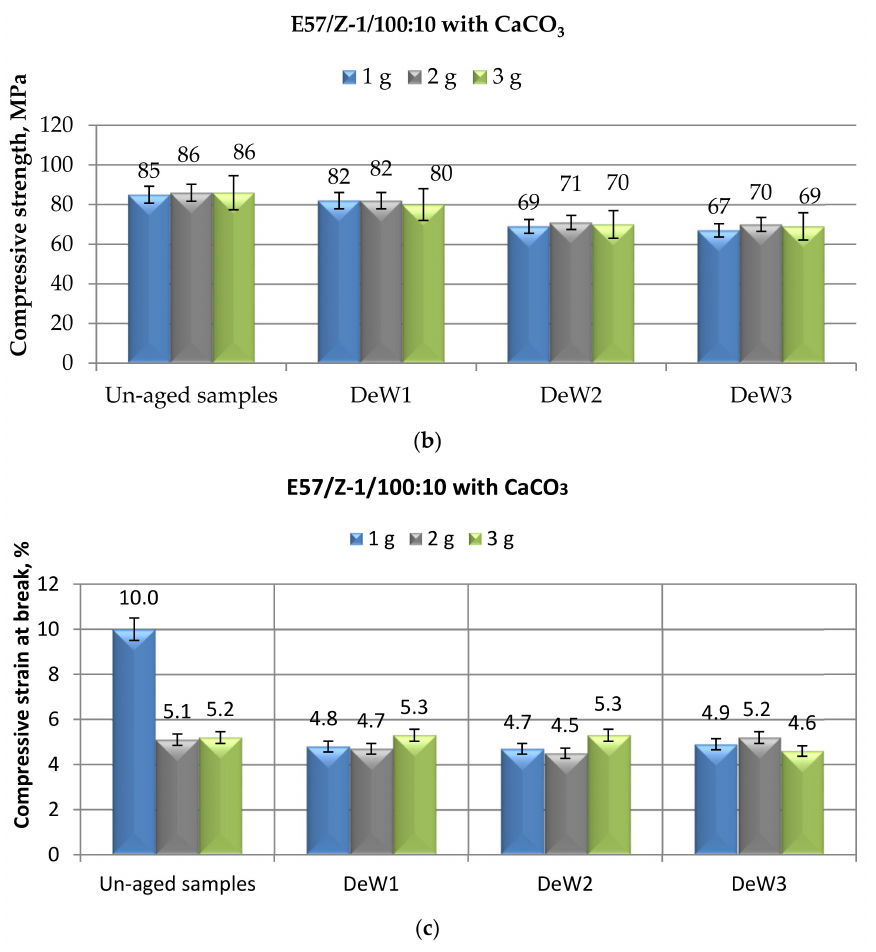
Figure 6. Results of mechanical tests performed in compression mode on CaCO 3 -filled E57/Z-1/100:10 specimens after different immersion times (i.e., 1, 6, and 10 months) in demineralized water, in terms of ( a ) Compressive modulus; ( b ) Compressive maximum strength; ( c ) Compressive strain at break.